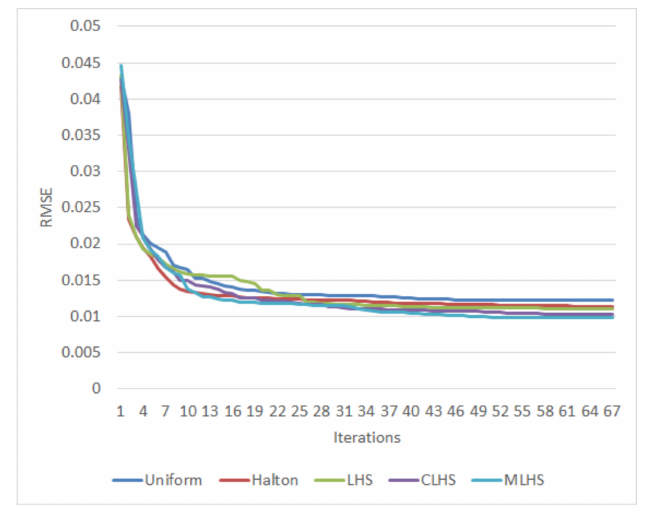
Figure 6. Comparison of convergence using multiple types of initialization methods: Uniform sampling, Halton sampling, classic Latin Hypercube sampling, (LHS), Centered Latin Hypercube sampling (CLHS), Maximin Latin Hypercube sampling (MLHS).